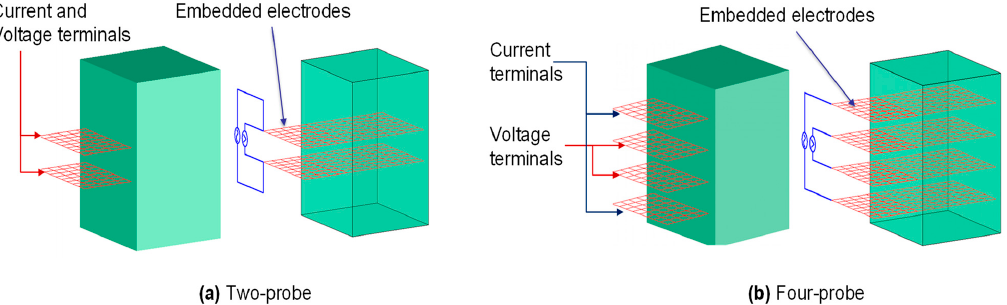
Figure 3. Different electrode configurations for resistance measurement in the cementitious matrix: ( a ) two-probe technique; ( b ) four-probe technique.